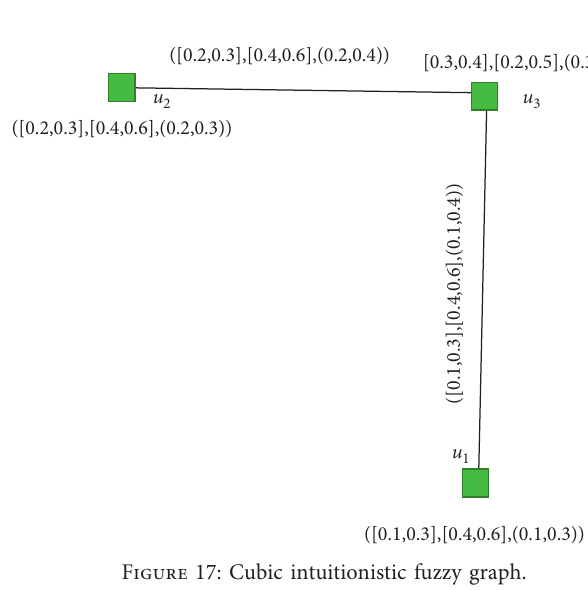
Figure 17: Cubic intuitionistic fuzzy graph.